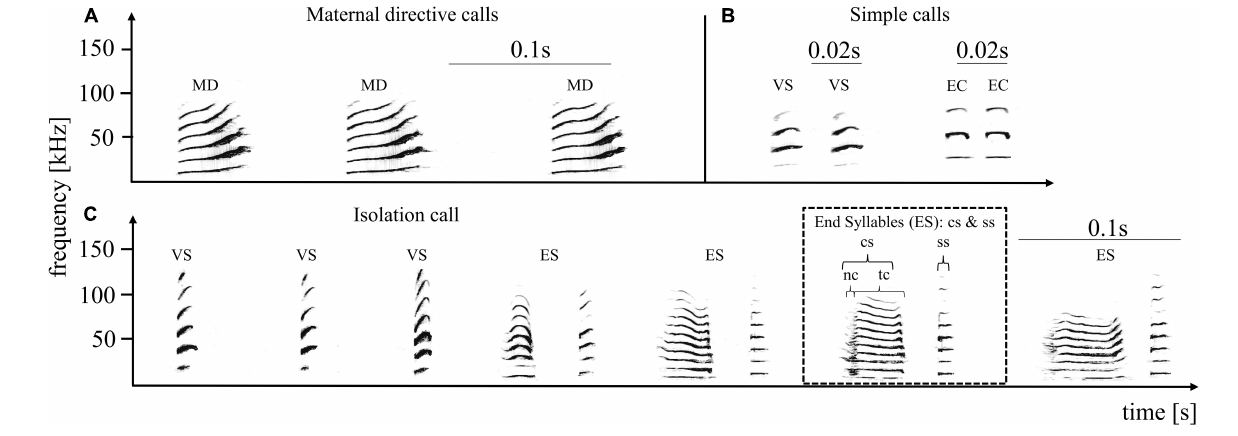
FIGURE 1 | Pup-directed – (A) and adult-directed vocalizations (B) from an adult female and the pup-directed vocalization of an adult male (C) . The upper panel shows three successive directive calls produced by an adult female (directed toward the own pup), and four adult-directed calls produced by an adult female. Adult-directed female vocalizations included variable short syllables (VS) and echolocation calls (EC), summarized as simple calls. The lower panel shows one multisyllabic isolation call produced by an adult male. Maternal directive calls (A) are always produced in monosyllabic series, from three up to 15 syllables. An isolation call (C) is composed of simple tonal calls (variable short syllable: VS) followed by the end syllables (ES). End syllables are composed of two syllable types, the composite (cs) and the stereotyped short syllable (ss). The cs part is further composed of a facultative noisy part (nc) succeeded by a tonal part (tc). Several simple frequency modulated syllables followed by several end syllables result in a typical isolation call. The spectrograms depict frequency (in kHz) as a function over time (in seconds) and were generated using a 1042 point fast Fourier transform and a Hamming window with 87.5%